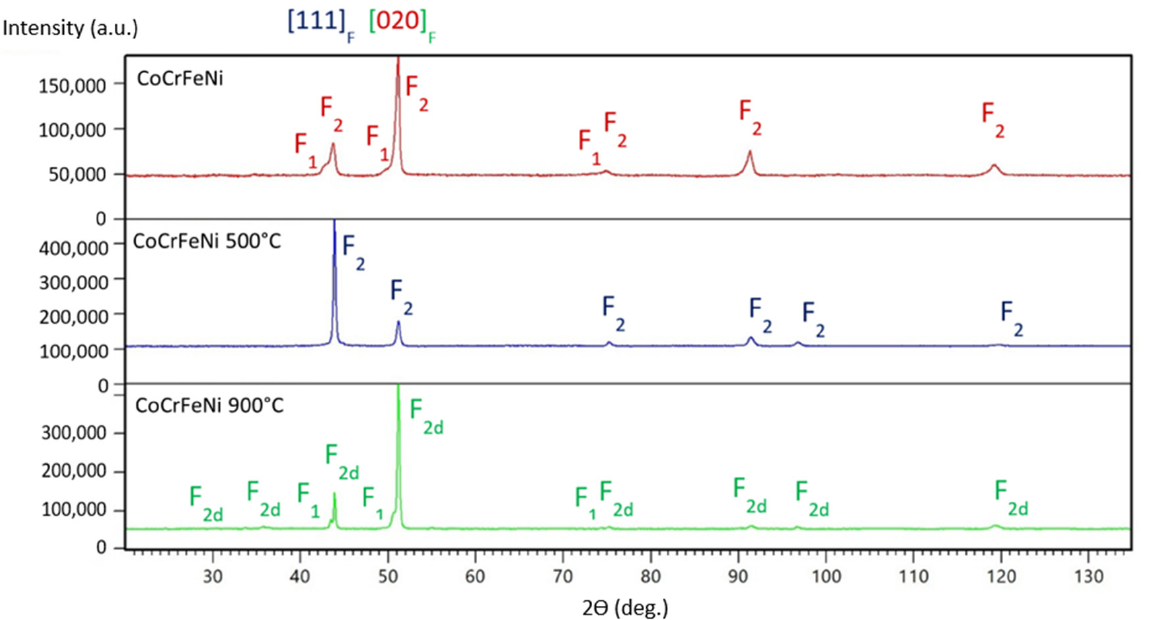
Figure 2. X-ray diagrams of as-cast CoCrFeNi samples and those annealed at different temperatures. The identified phases have been marked according to the graphic symbols described in Table 2. The directions of the mechanical textures are shown at the top of the diagram set.